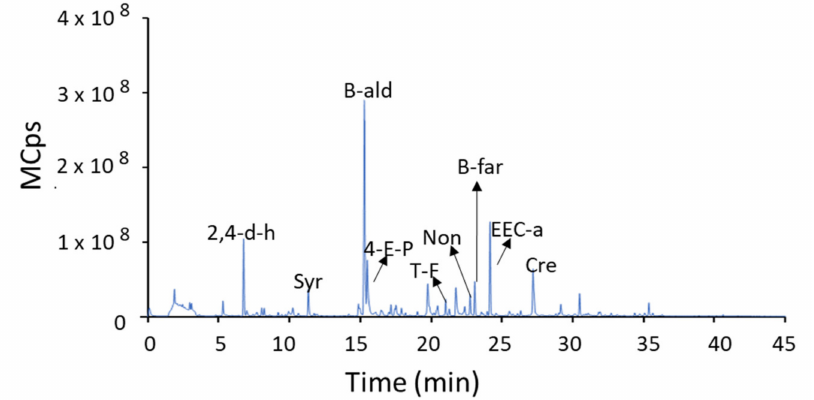
Figure 1. Representative chromatogram of the aromatic profile of thermal sterilized California-style black olives. Syr: styrene; 4-E-P: 4-ethenyl-pyridine; t-F: trans-farnesol; B-ald: benzaldehyde; Non: nonanal; EEC-a: ethyl ester cyclohexanecarboxylic acid; Cre: creosol; 2,4-d-h: 2,4-dimethyl-hexane; b-far: